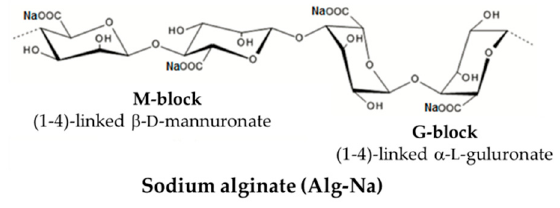
Figure 10. The structure of sodium alginate.